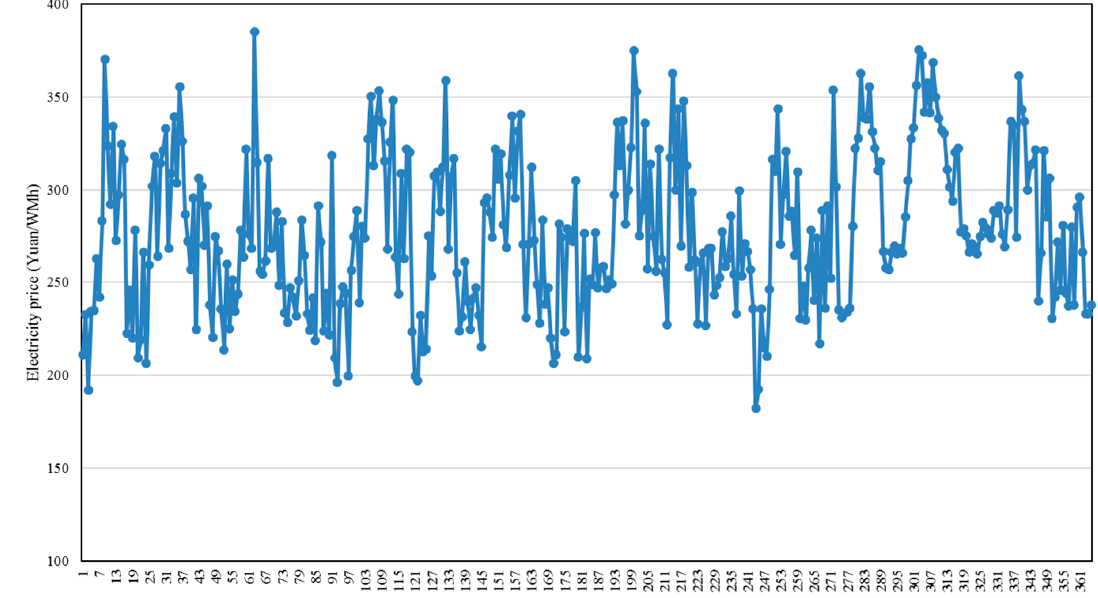
Figure 2. Daily electricity price time series from 1 January to 31 December.